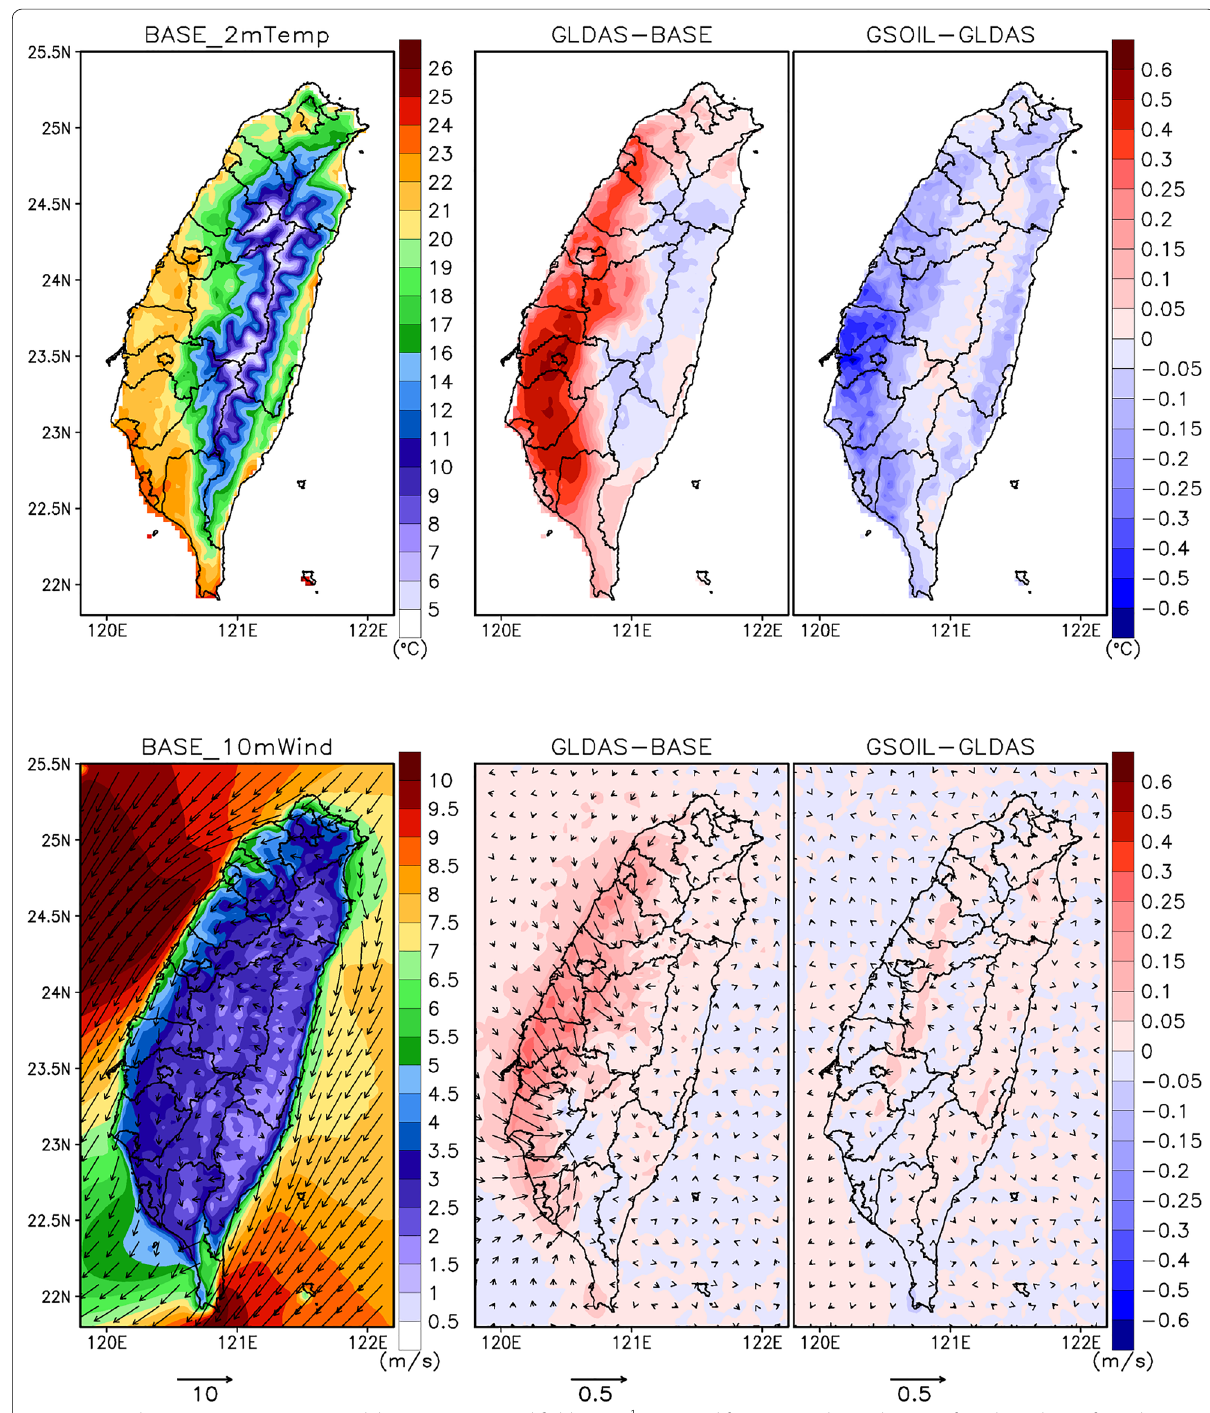
Fig. 8 (Top) The 2‑m temperature (°C) and (bottom) 10‑m wind fields (m s − 1 ) averaged from 6‑month simulation. Left to the right are from the WRF‑base run, difference between WRF‑GLDAS and WRF‑base, and difference between WRF‑GSOIL and